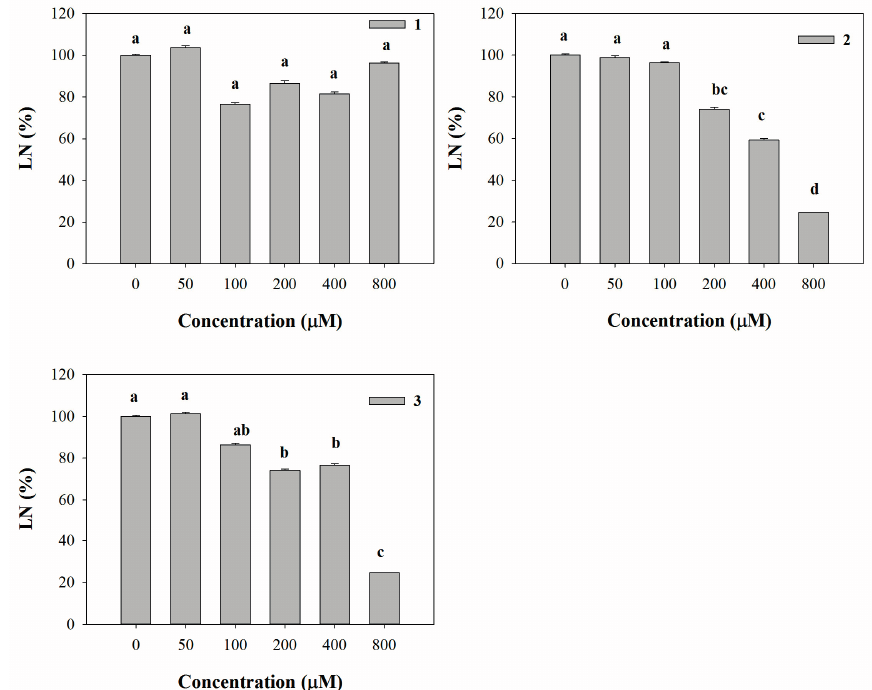
Figure 2. Leaf number (LN) of A. thaliana seedlings treated with synthetic coumarins 1 – 3 Data are expressed as percentage of the control. Different letters (a–d) along the bars indicate significant differences at p ≤ 0.05). Homoscedastic data were analyzed by ANOVA with Tukey’s test, whereas the heteroscedastic ones were analyzed with Tamhane’s T2. N = 5.